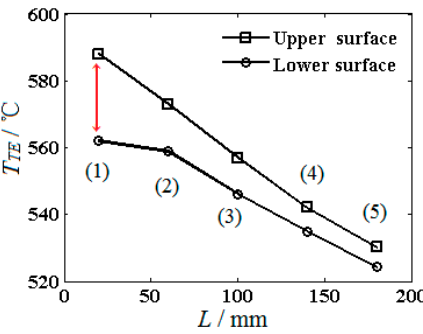
Figure 6. Variation in temperature difference of thermoelectric modules with time.